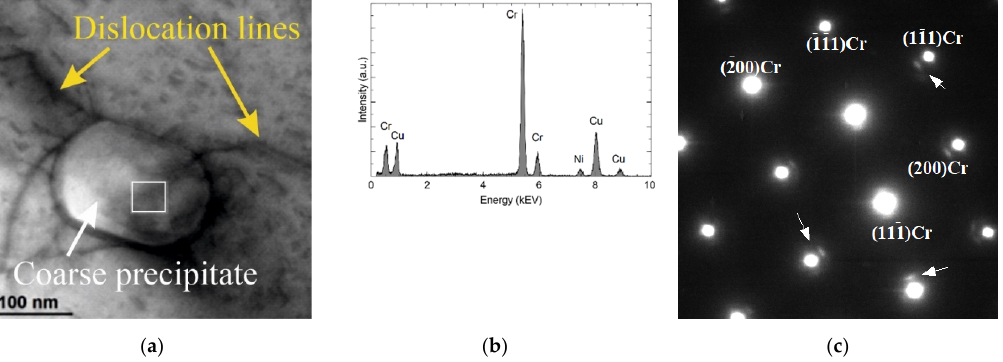
the HAADF image ( b ). Results of the chemical composition analysis in areas marked as A, B and C, respectively ( c – e ).